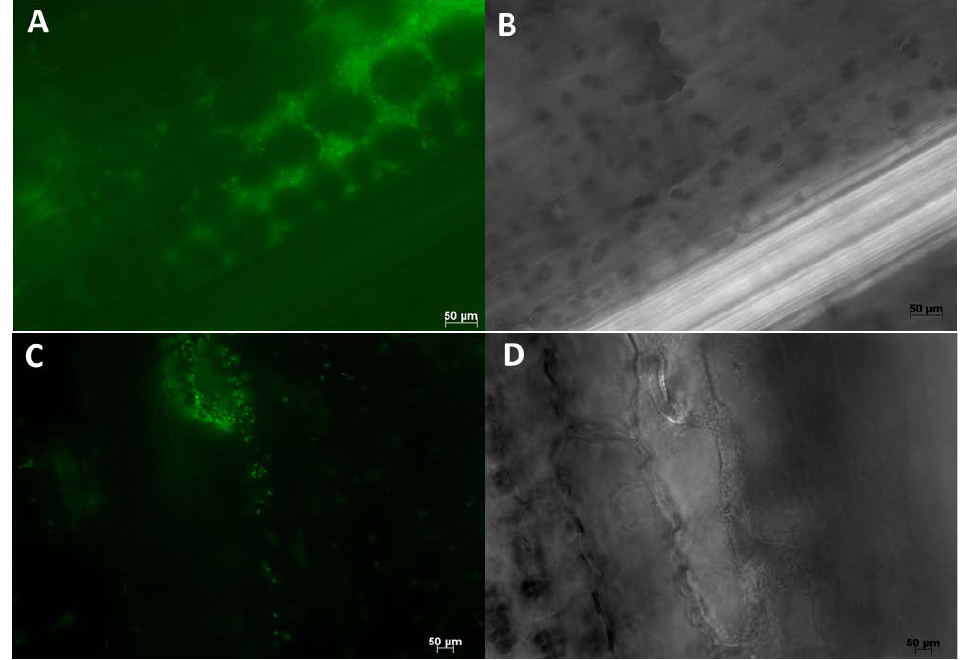
Figure 5. Maize (hybrid 29B17) leaves were colonized by WP5 gfp visualized under 630× magnification. Image on the left ( A , C ) were taken with the GFP filter, and images on the right ( B , D ) were taken without the GFP filter. WP5 gfp was observed in the intercellular spaces of cell layers and stomatal chambers.